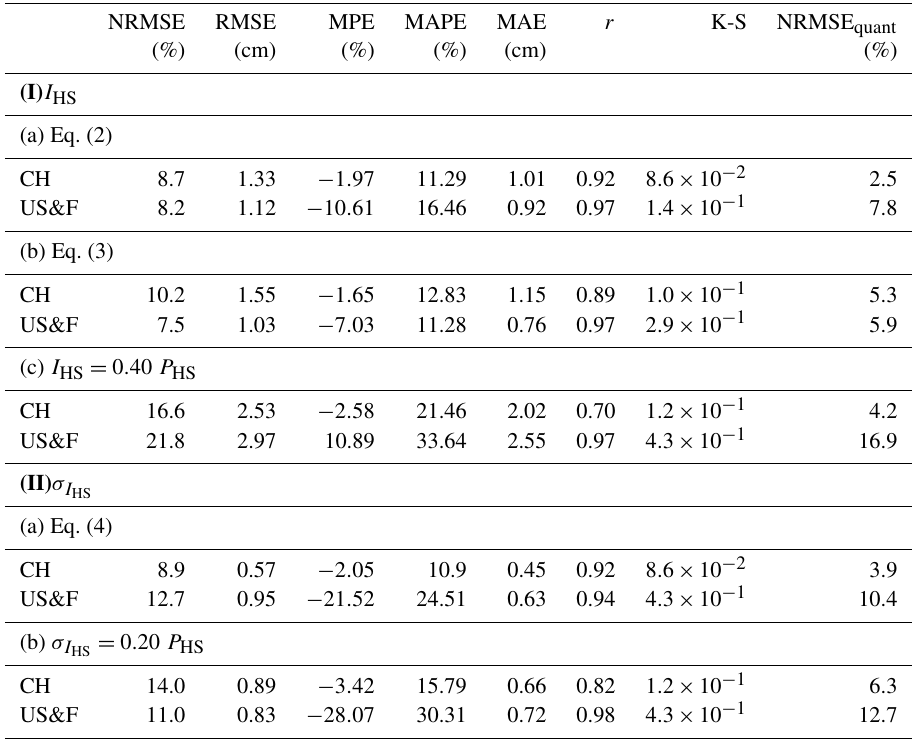
Table 1. Performance measures between measurement and parameterization of (I) spatial-mean snow depth interception I HS with (a) Eq. (2), (b) Eq. (3), and (c) a baseline model and of (II) standard deviation of snow depth interception σ I Statistics are shown for the development data set from the eastern Swiss Alps (CH) and for the combined validation data set